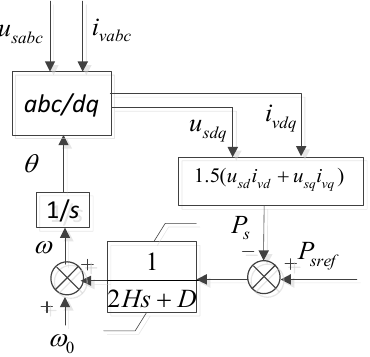
Figure 4. Block diagram of power synchronization loop PSL.